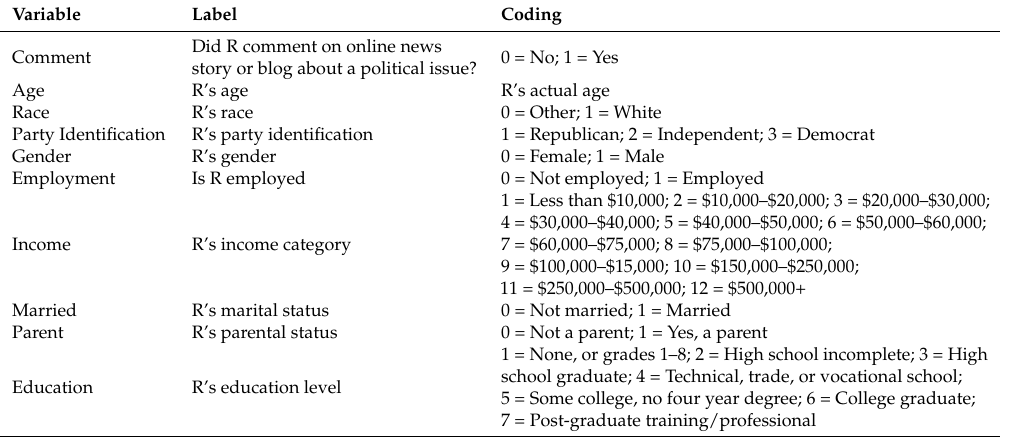
Table A3. Summary of variables used during the 2012 regression